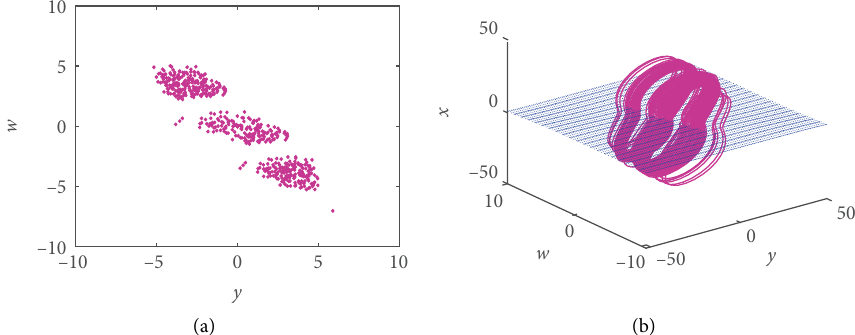
Figure 7: (a) Poincaré mapping projected onto 푦−푤 plane and (b) space diagram of Poincaré